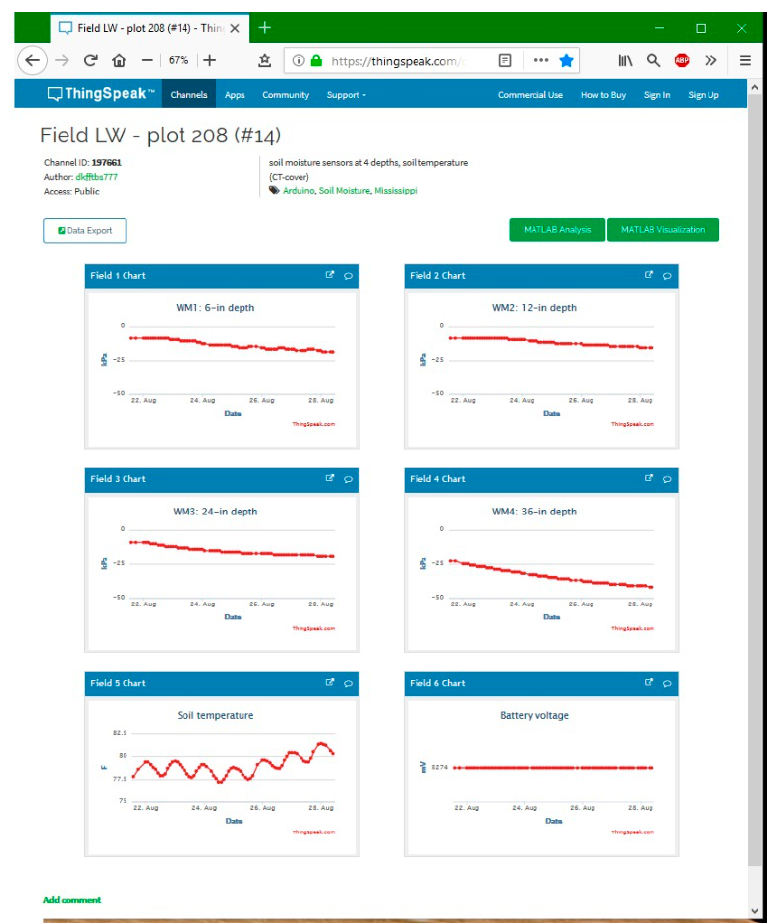
Figure 6. Sample of sensor node data uploaded to a ThingSpeak webpage.